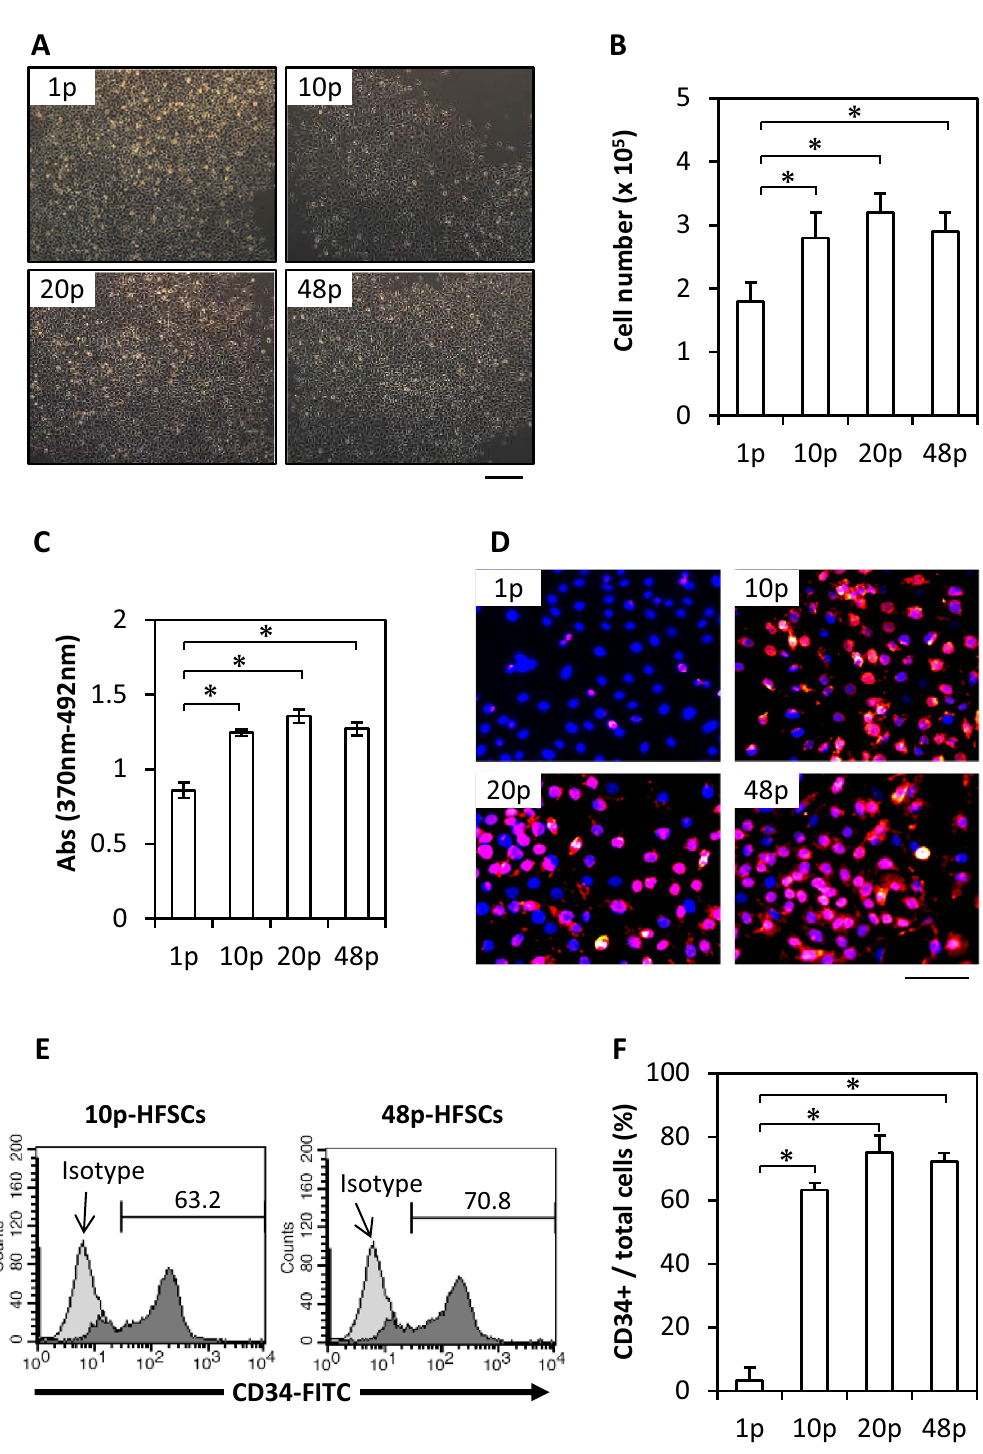
Figure 3. Characterization of HFSCs passaged with M-CnT for long term. ( A ) Morphology results of 1p-, 10p-, 20p-, and 48p-HFSCs cultured with M-CnT. Scale bar = 50 mm. ( B ) Cell proliferation of 1p-, 10p-, 20p-, and 48p-HFSCs cultured with M-CnT. * p < 0.05. ( C ) BrdU proliferation assay results of p1-, 10p-, 20p-, and 48p-HFSCs cultured with M-CnT. * p < 0.05. ( D ) Immunocytochemical results of CD34-positive cells among 1p-, 10p-, 20p-, and 48p-HFSCs cultured with M-CnT. CD34-positive (red) and nuclei (blue) were stained with an Alexa546 labeled secondary antibody and DAPI, respectively. Scale bar = 50 mm. ( E ) Flow cytometry results of 10p- and 48p-HFSCs cultured with M-CnT. ( F ) CD34-immunopositivity of HFSCs cultured with M-CnT for 48 passages. * p <